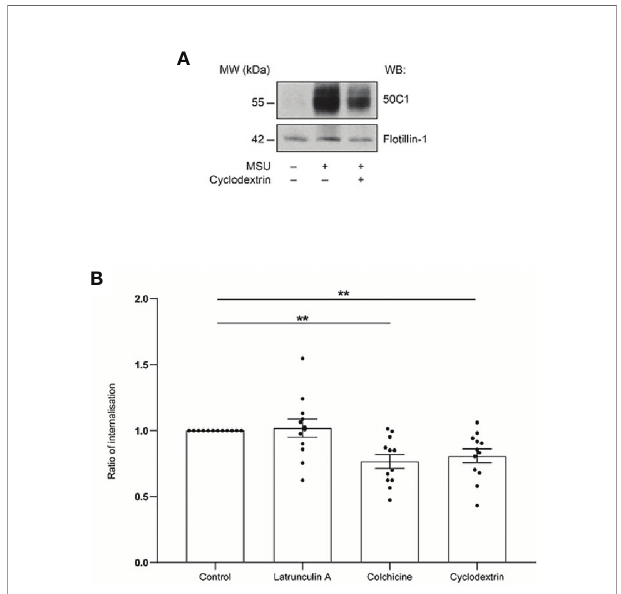
FIGURE 2 | Antibody-induced cross-linking and internalization of CLEC12A is dependent on cholesterol-rich, membrane domains and microtubules. (A) Methyl- b -cyclodextrin-treated neutrophils were lysed in cold, 1% Nonidet P-40 after MSU stimulation and the insoluble pellet of the lysate immunoblotted with 50C1. These data are representative of 3 independent experiments. (B) Cell-surface CLEC12A expression of neutrophils treated with all compounds or diluent ( control ) was determined by fl ow cytometry after CLEC12A cross-linking. These data are representative of 12 independent experiments (Mean± SEM). Statistical analysis: One way ANOVA and Fischer ’ s LSD. ** P <